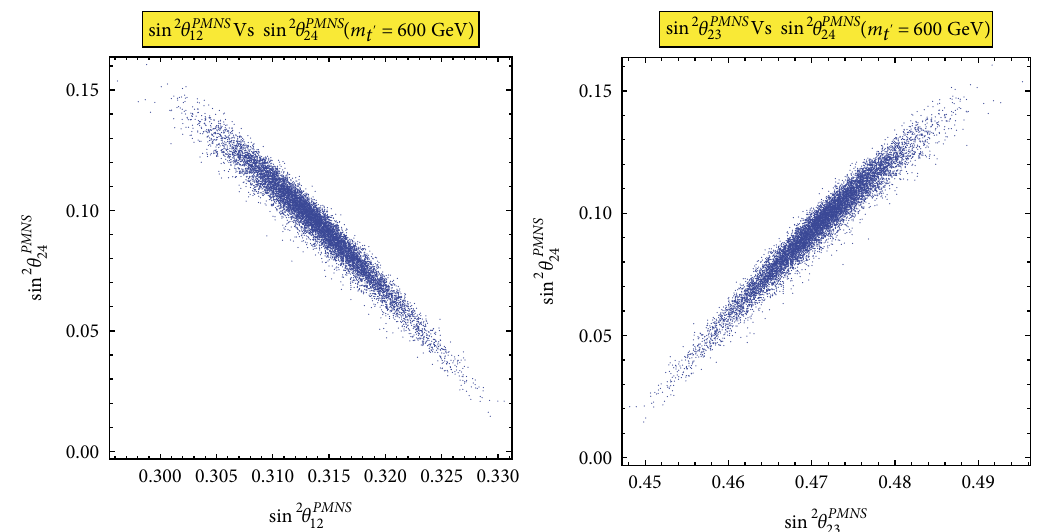
Figure 3: Correlation plot for sin 2 𝜃 𝑃𝑀𝑁𝑆